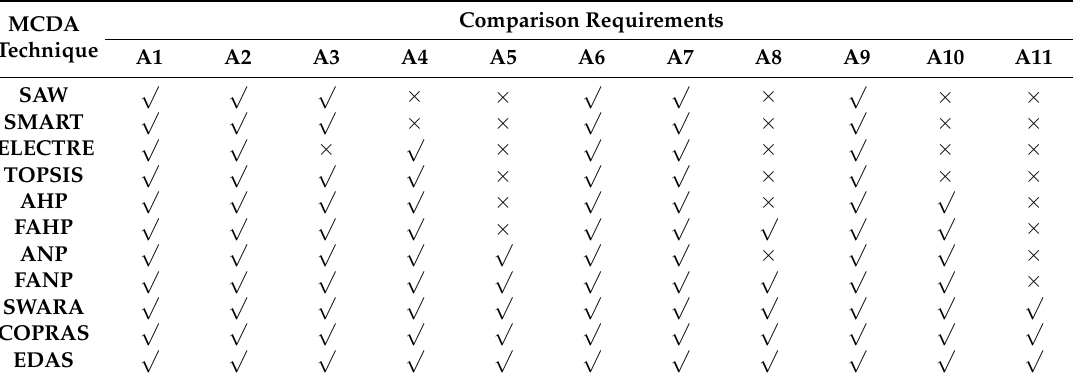
Table 2. Comparison between MCDA